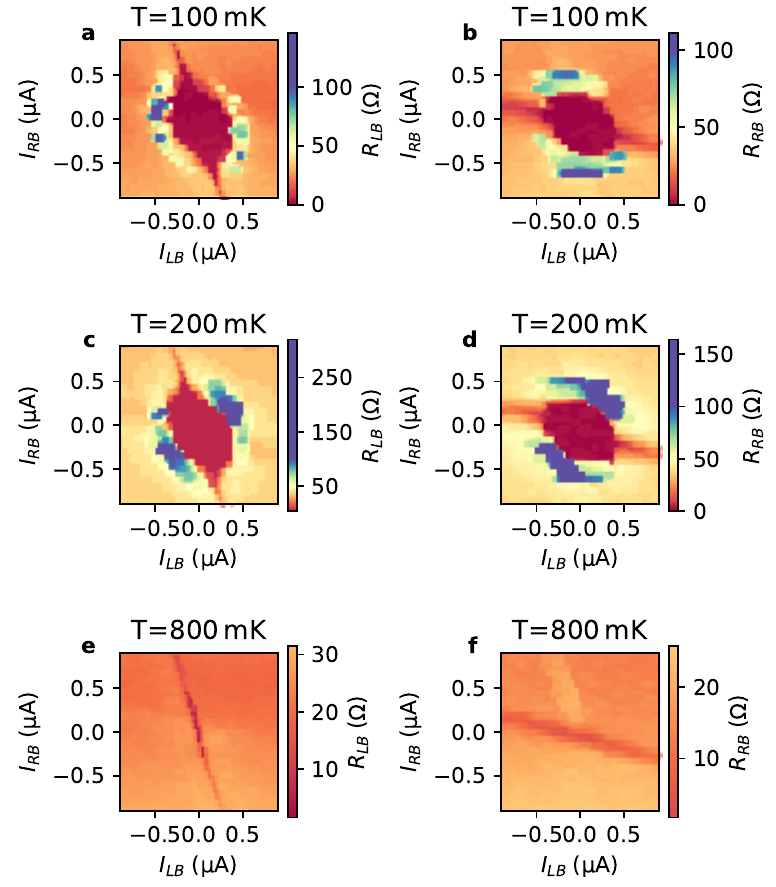
Figure 4. Differential resistance maps at various temperatures: Left column ( a , c , e ) shows the differ- ential resistance R LB , right column ( b , d , f ) R RB , accordingly. The temperatures displayed in the rows from top to bottom are 100mK, 200mK and